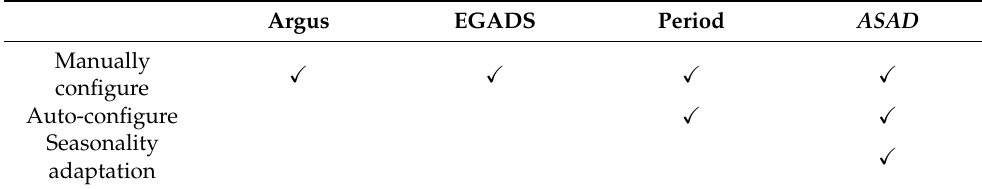
Table 7. Seasonal adaptive function